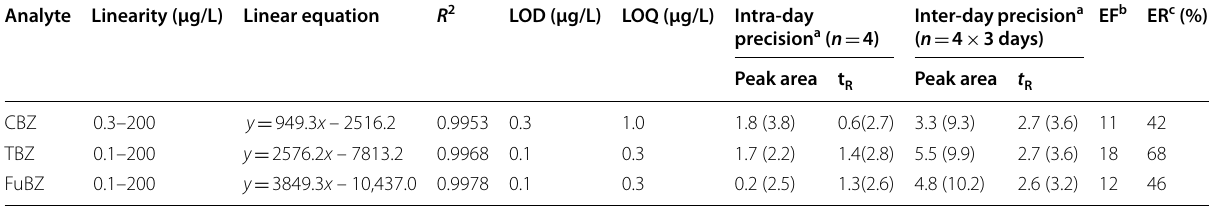
a Precisions were evaluated and expressed as the %RSD of peak area and retention time ( t R ) for the concentration of 50 and 20 μg/L (in the parentheses) b Enrichment factor (EF): ratio of the slopes of the calibration curves obtained with preconcentration ( S ex ) and without preconcentration ( S o ) ] × 100 ; where V c Extraction recovery: [ EF × V ex V ex and V o are volumes of extraction phase (~ 0.380 mL) and original sample phase (10.00 mL), respectively o